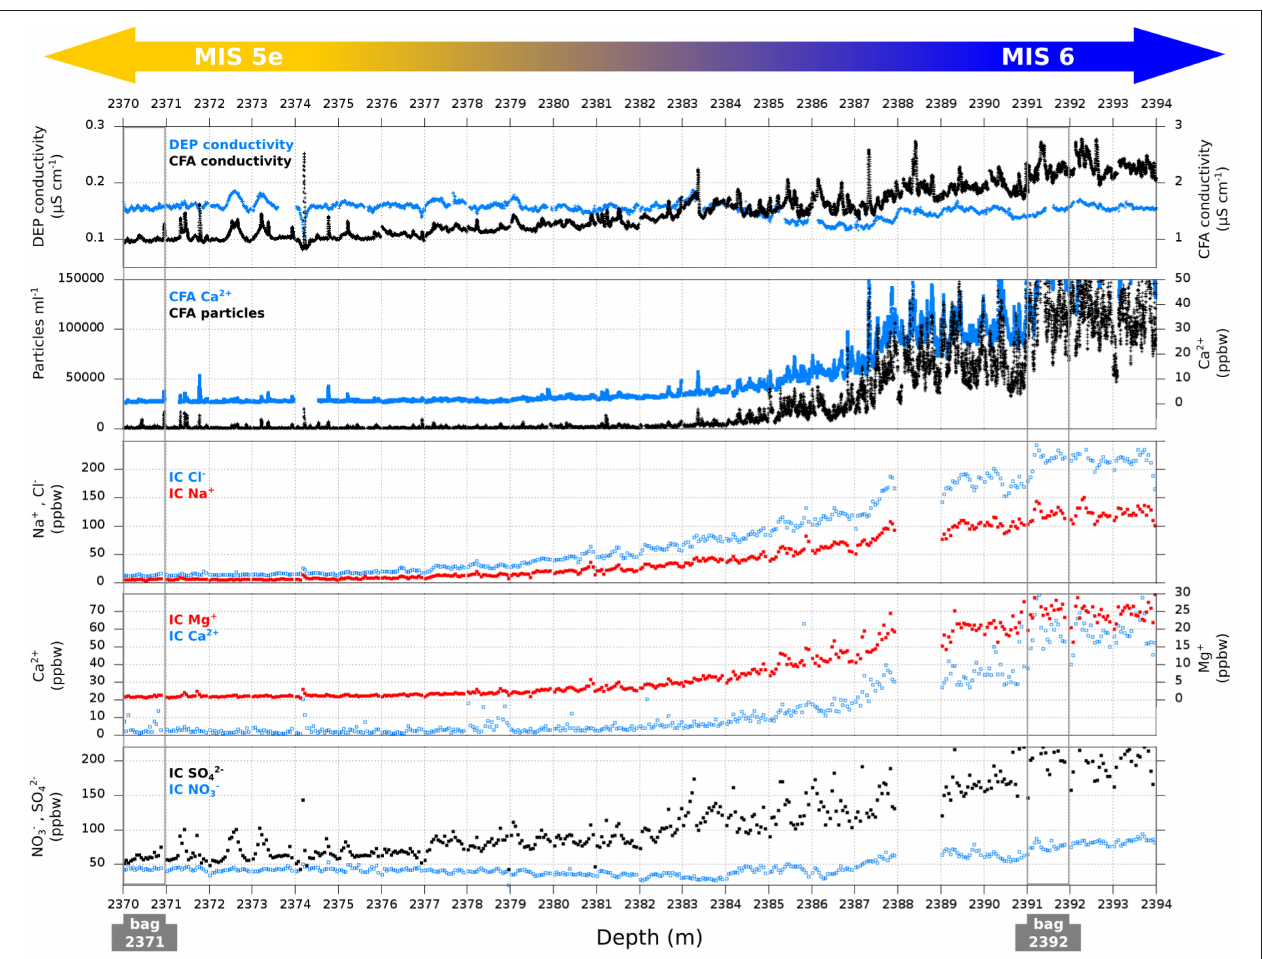
FIGURE 2 | DEP, CFA, and IC data along the transition between MIS5a and MIS6 (2370–2394 m). The positions of bags 2371 and 2392 are marked. The concentrations of solid particles have been previously presented by Wegner et al. (2015), all other datasets are presented here for the first